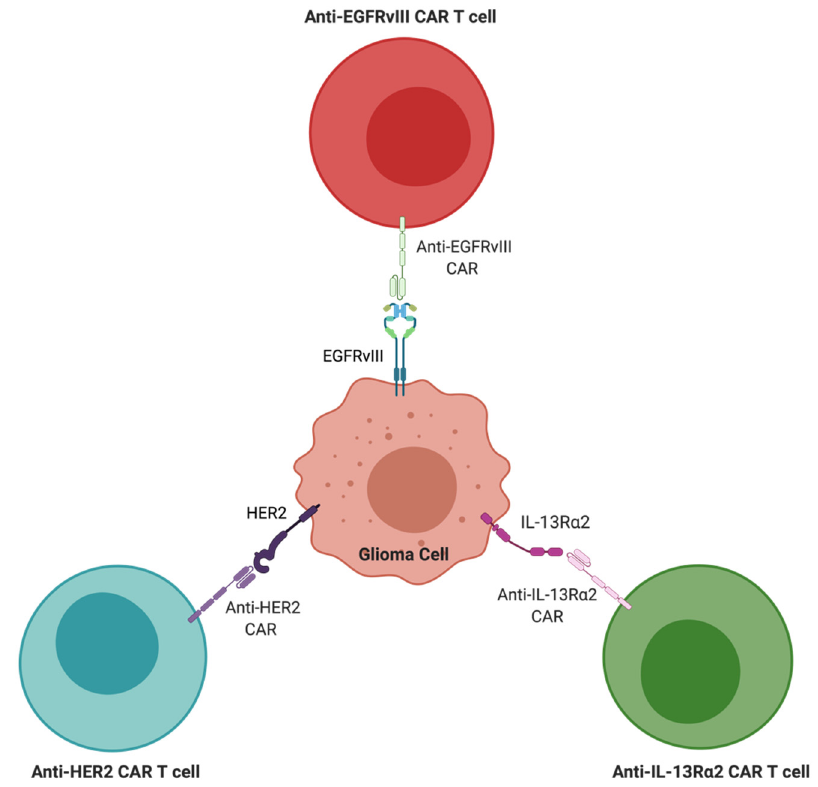
Figure 2. Schematic representation of different CAR T-cells and their targets. Represented anti-HER2, anti-IL13R α 2, and anti-EGFRvIII CARs. All three antigens are represented in the same cell for the purpose of the graphic.